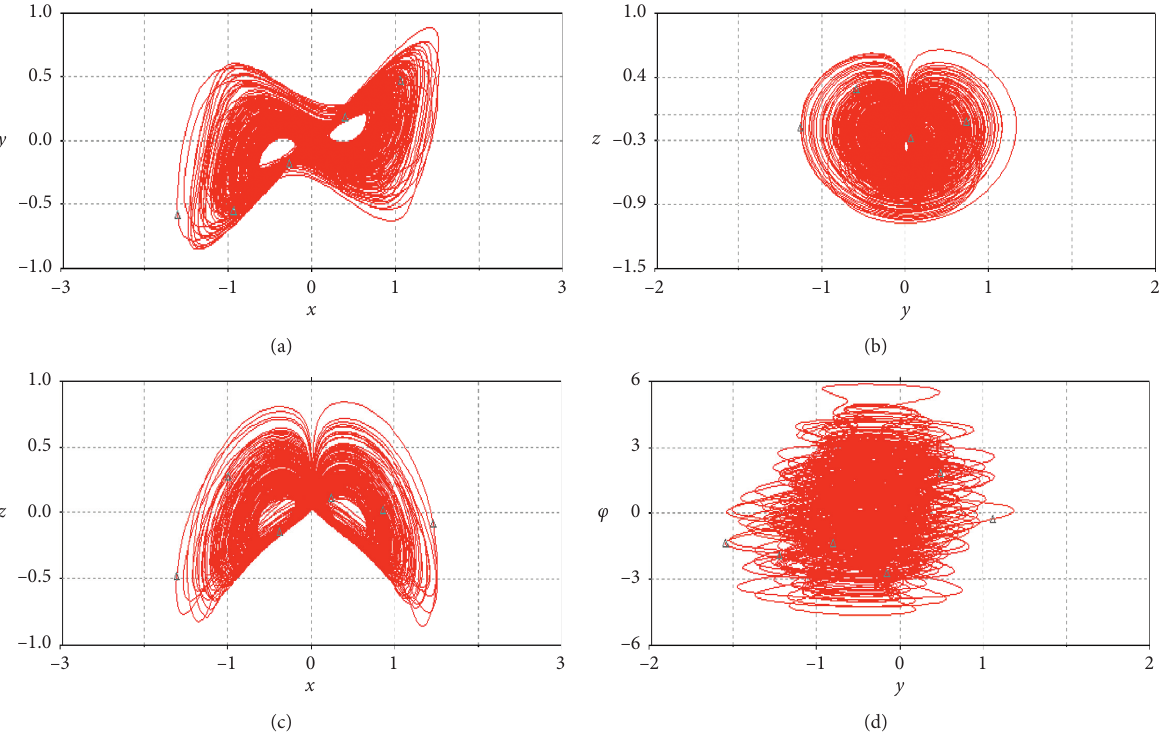
Figure 12: Simulation results obtained from Multisim software: (a) attractor on the x-y plane, (b) attractor on the y-z plane, (c) attractor on the x-z plane, and (d) attractor on the y - φ plane.